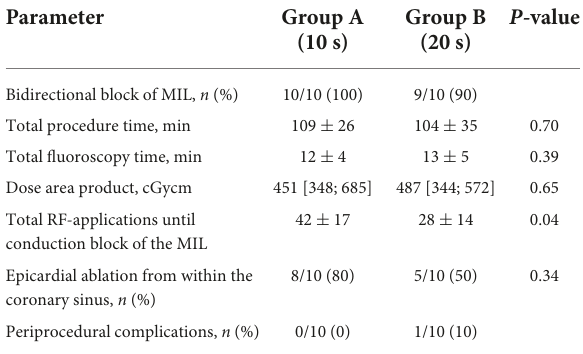
TABLE 2 Procedural